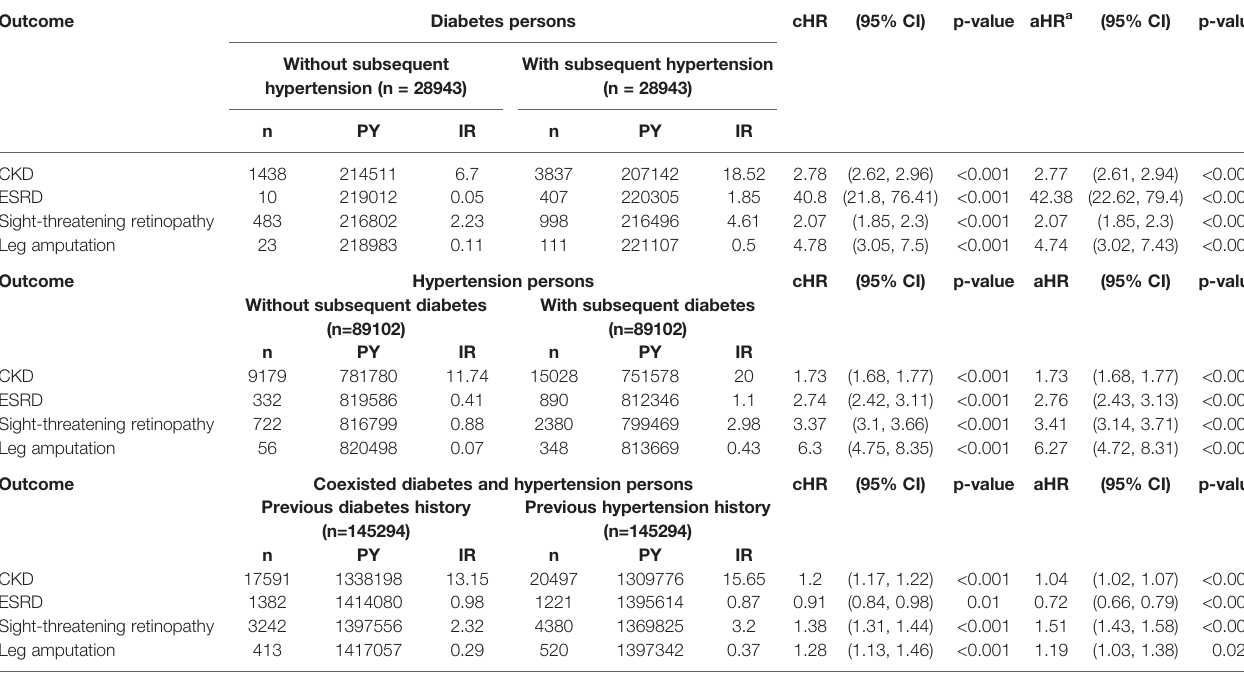
TABLE 4 | HRs and 95% CIs for the outcomes of CKD, ESRD, retinopathy, and amputation. Outcome Diabetes persons cHR (95% CI) Without subsequent With subsequent hypertension hypertension (n = 28943) (n =